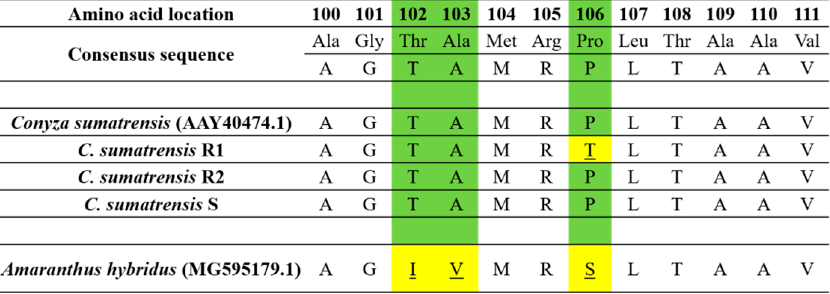
Figure 1. Partial sequence of 5-enolpyruvylshikimate-3-phosphate synthase (EPSPS) DNA isolated from the R1, R2 and S populations of C. sumatrensis and compared with Amaranthus hybridus R-glyphosate.